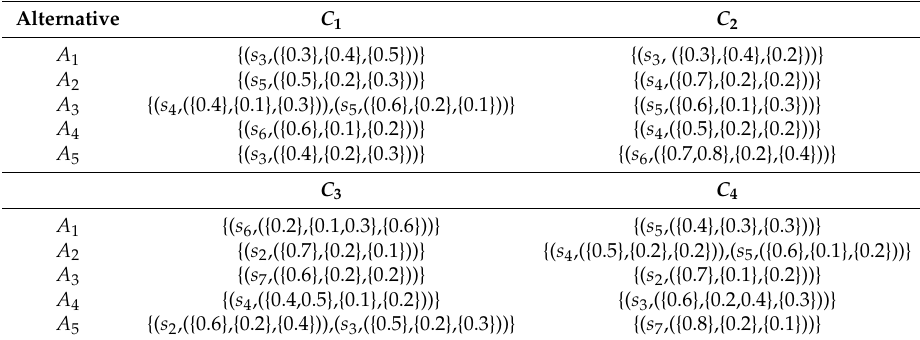
Table 3. Decision matrix D 3 .